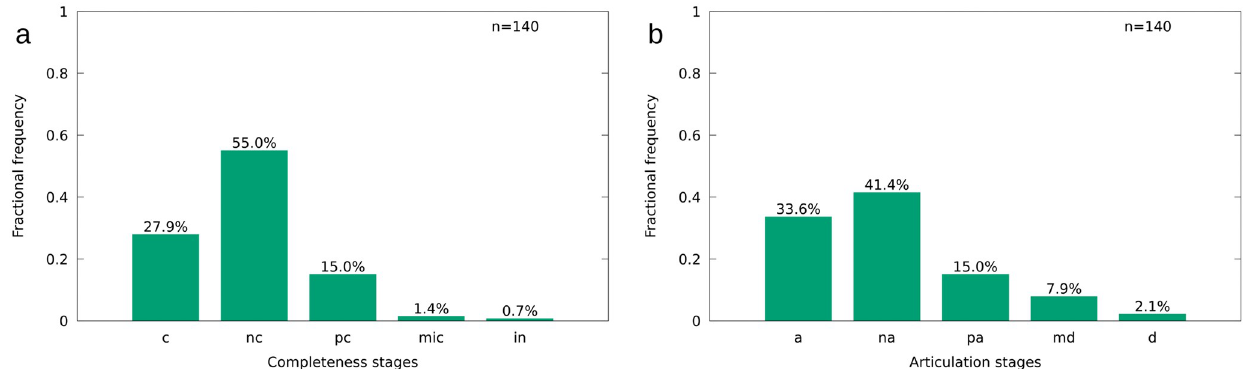
Fig 8. Completeness (A) and articulation (B) of T . formosa from Vallecillo in percent of the total number of individuals. Completeness stages differentiated here (Fig. 8A) include complete (c), nearly complete (nc), partially complete (pc), mostly incomplete (mic) and incomplete (in) specimens. Articulation stages differentiated (Fig. 8B) include articulated (a), nearly articulated (na), partially articulated (pa), mostly disarticulated (md) and disarticulated (d) individuals.